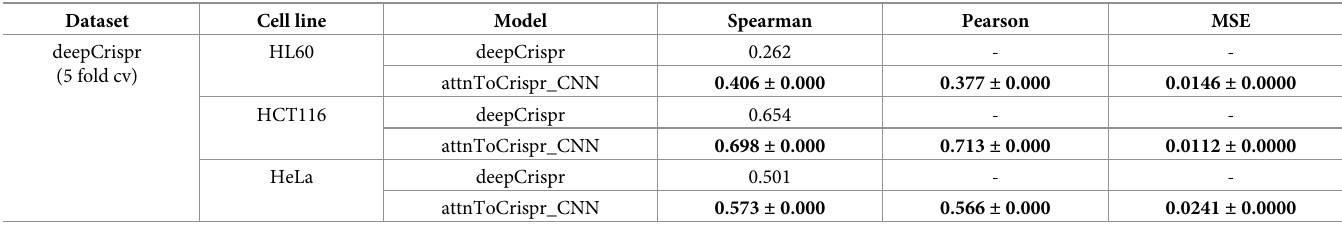
Table 4. Model performances of negative experiment data in HL60, HCT116, and HeLa cell lines with 5-fold cross-validation.